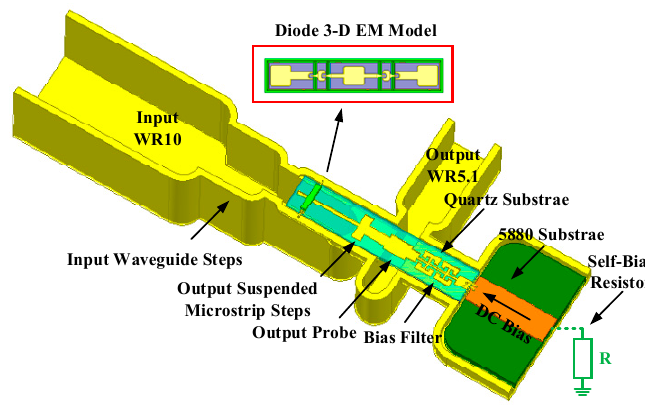
Figure 4. The configuration of the 135-190 GHz balanced frequency doubler under self-bias.